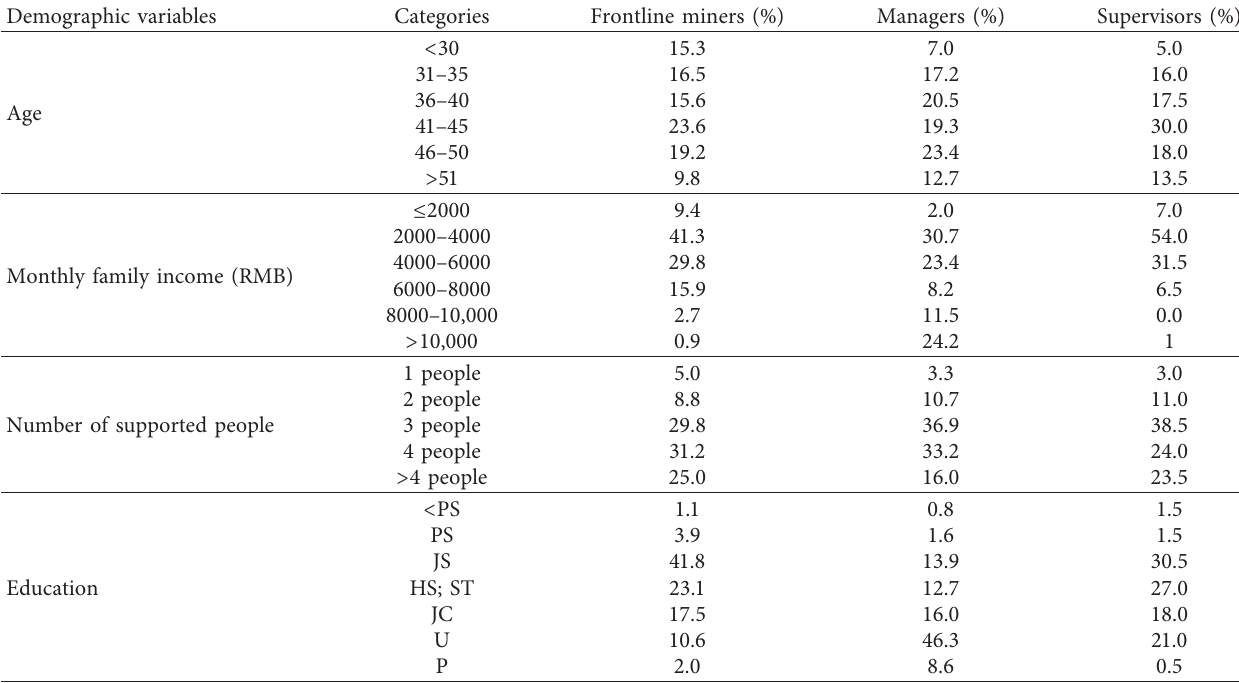
Table 2: The percentage of demographic variables of all